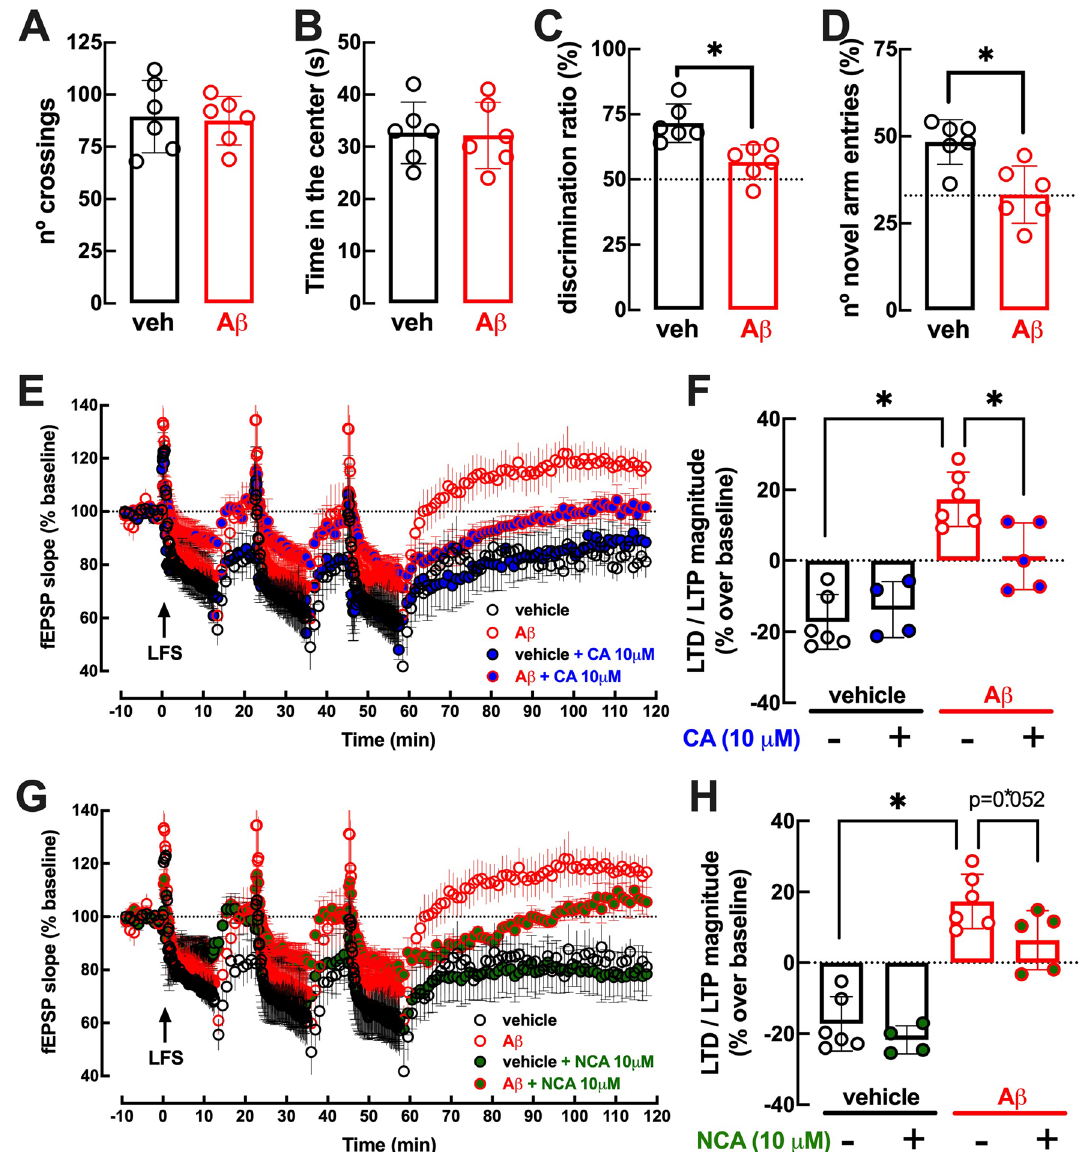
Figure 4. Mice injected intracerebroventricularly (icv) with β-amyloid peptide 1–42 (Aβ 1-42 ) displayed a selective disruption of hippocampal-dependent memory performance, accompanied by a paradoxical alteration of hippocampal synaptic plasticity, which was attenuated by exposure to the chlorogenic acids 3-(3,4-dihydroxycinnamoyl)quinic acid (CA, 10 µM) and 5-O-(trans-3,4-dihydroxycinnamoyl)-D-quinic acid (NCA, 10 µM). Fifteen days after an icv challenge with Aβ 1-42 (2 nmol), Aβ-treated mice (red symbols) displayed no alteration of spontaneous locomotion ( A ) assessed by the number of crossings in an open field test or anxiety, assessed as the time in the more aversive central area of the open field ( B ), compared with control (vehicle-treated mice; black symbols). In contrast, Aβ-treated mice displayed hippocampal-dependent memory deficits, as assessed in the object displacement test ( C ) and two-visits Y-maze test ( D ). Slices from vehicle- treated mice displayed a pattern of long-term depression (LTD) after repeated low-frequency stimulation (LFS), which was not affected by CA (10 µM; blue symbols) ( E–F ) or NCA (10 µM; green symbols) ( G,H ). Slices from Aβ-treated mice displayed a shift from LTD to LTP after repeated low-frequency stimulation (LFS), which was attenuated by CA (10 µM) ( E–F ) or NCA (10 µM) ( G,H ). Data are mean ± S.E.M. of 4–6 experiments. * p < 0.05 versus control using a Mann Whitney test ( C,D ) or a Kruskal Wallis test followed by a Dunn’s post hoc multiple comparison test ( F,H